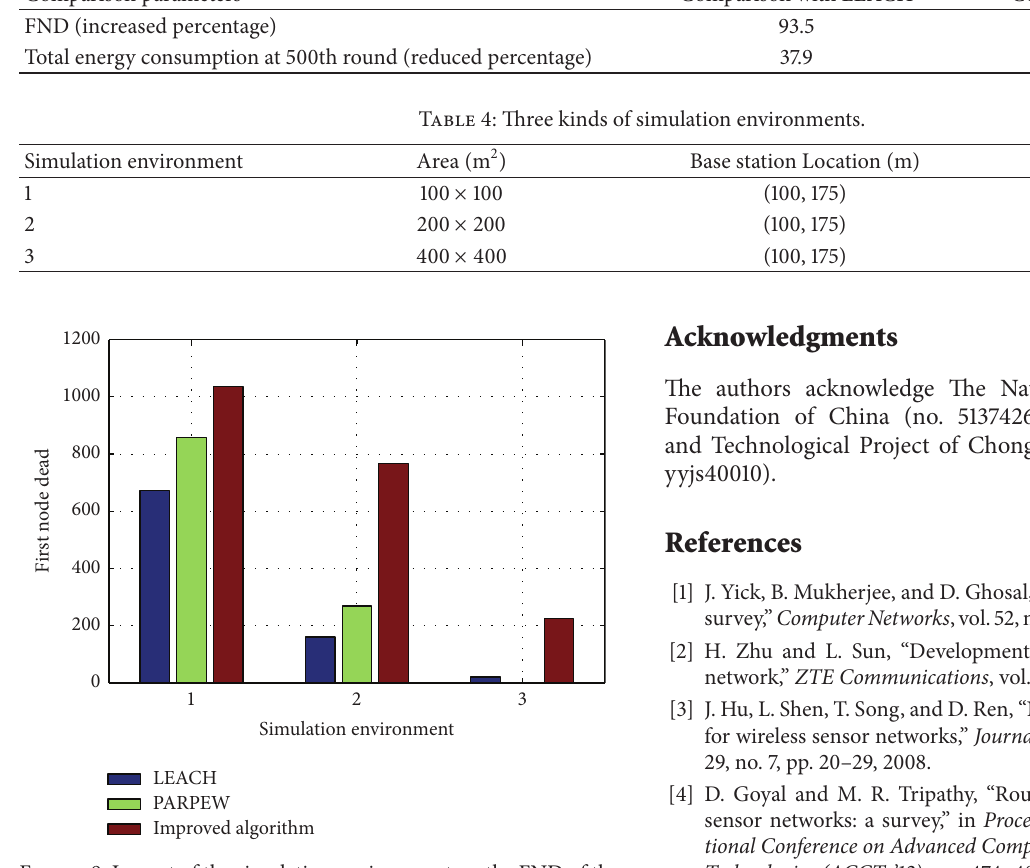
Figure 9: Impact of the simulation environment on the FND of the compared